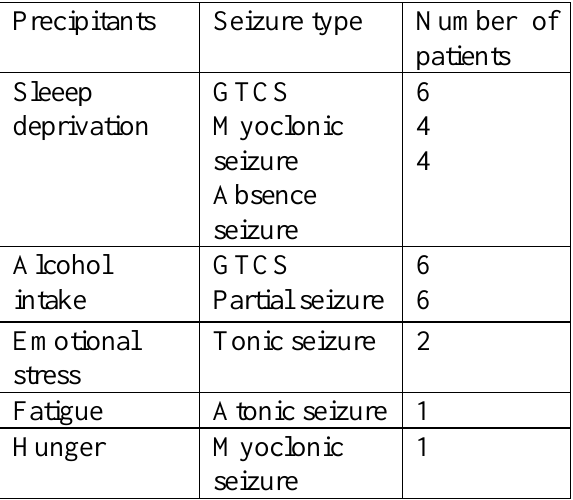
Table 3: Precipitants of seizure Precipitants Seizure type Number